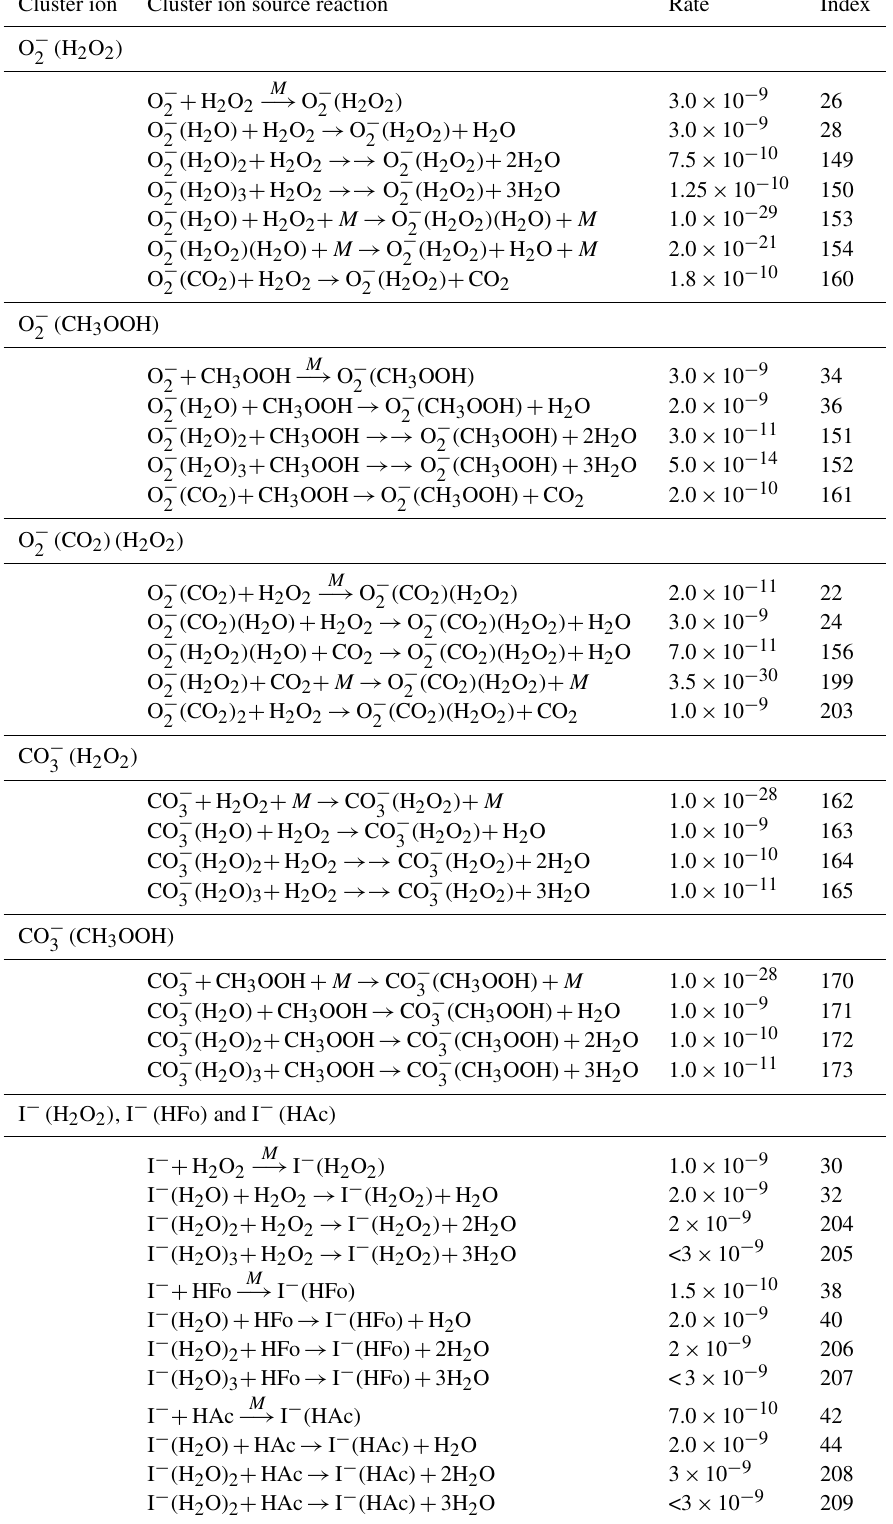
( H 2 O 2 ) , O − ( CH 3 OOH ) , O − ( CO 2 )( H 2 O 2 ) , I − ( H 2 O 2 ) , I − ( HFo ) and I − ( HAc ) 2 2 2